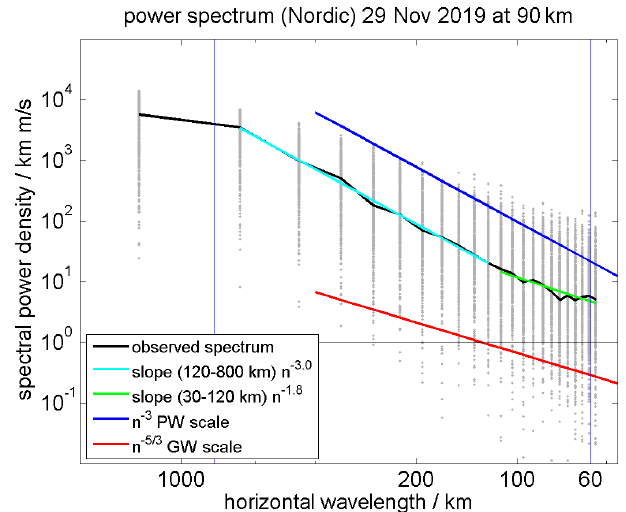
Figure 14. Estimated horizontal wavelength spectra for the Nordic Meteor Radar Cluster. The gray points are individual spectral ob- servations, the thin black line is the daily mean spectrum, the cyan and green lines represents fits to the respective wavelengths scale, and the blue and red lines are idealized slopes for planetary waves (PWs) and